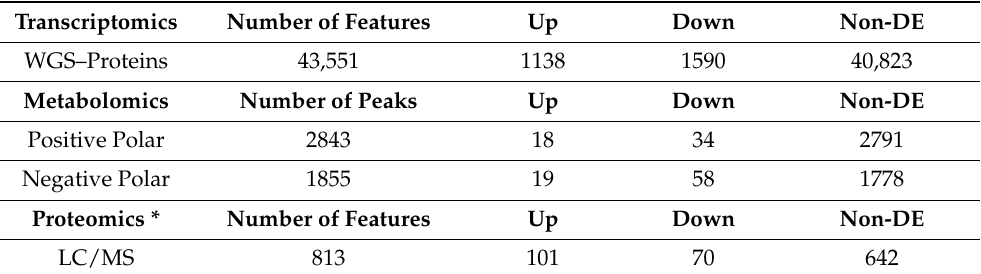
Table 1. Differentially expressed (DE) peaks and features in the leaves of young oil palm plants submitted to salinity stress selected by means of three distinct omics platforms (transcriptomics, metabolomics, and proteomics).